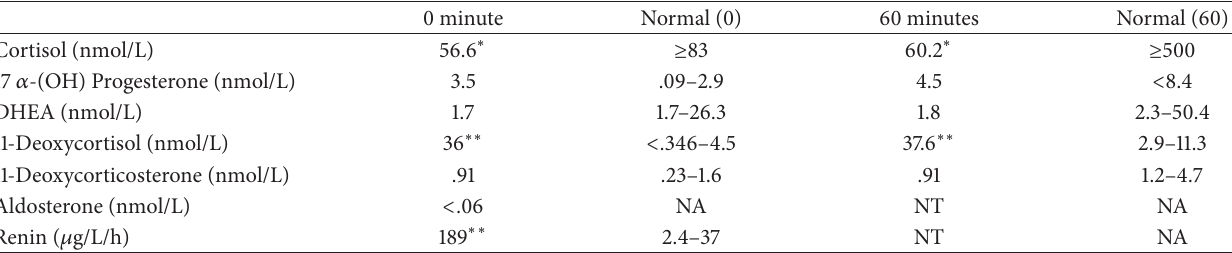
Table 1: Adrenal testing